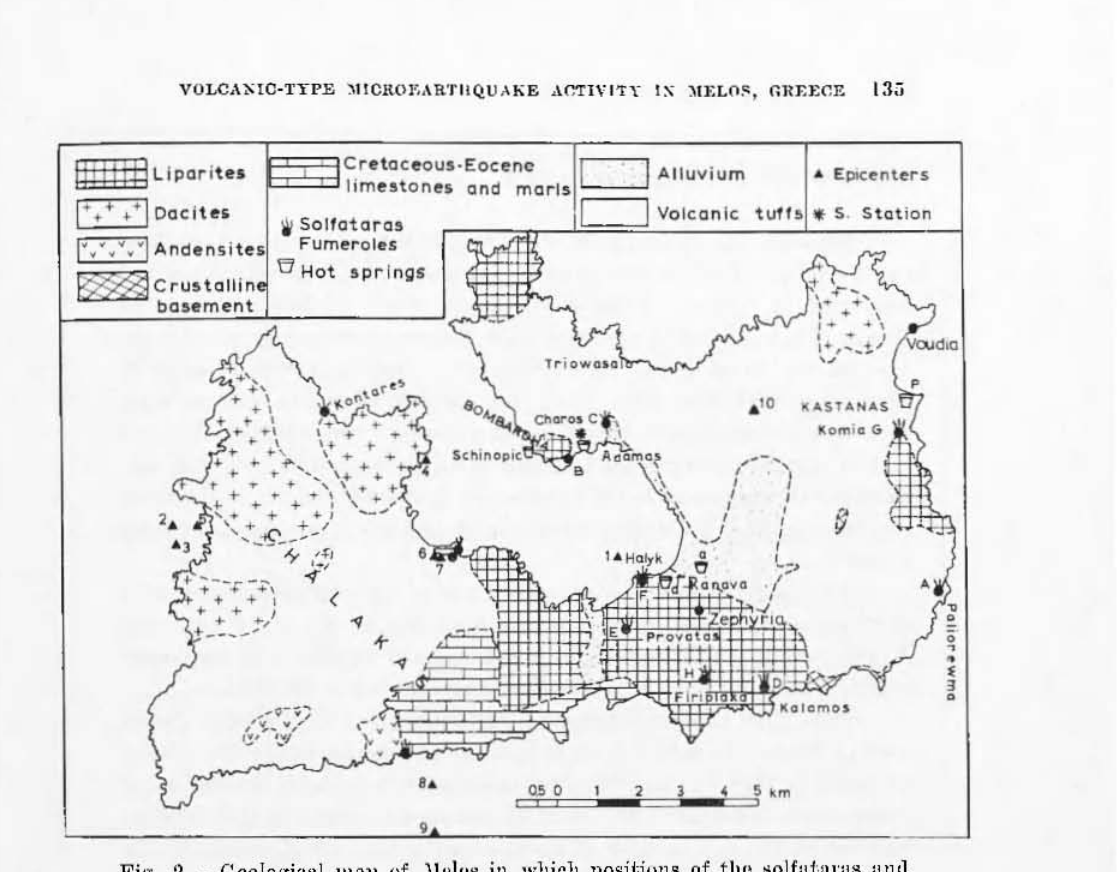
Fig. 2 _ Gcological m(lll of :\ldu!I in w11io11 positiulls of tlw ~olfat.lmU\